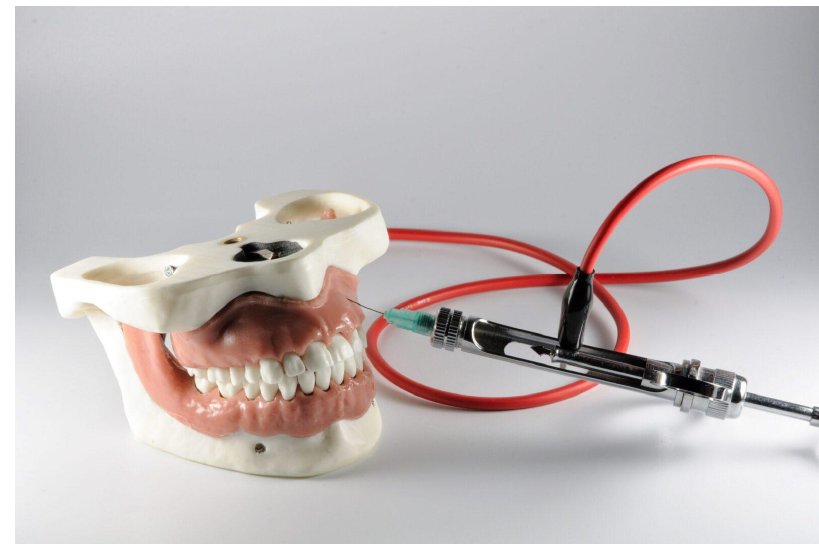
Figure 1. The theoretical part of training on an interactive anatomical table.